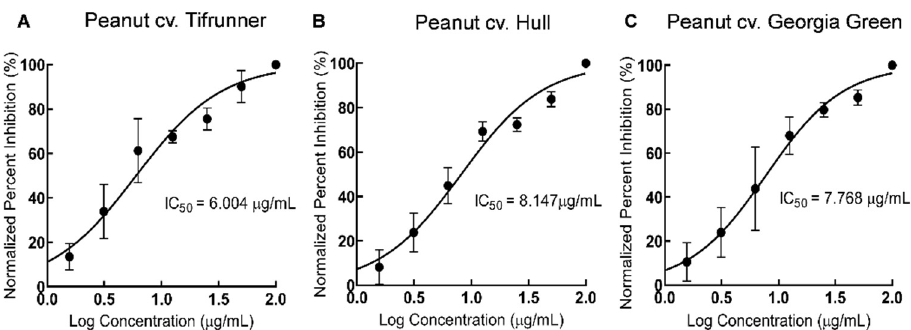
Figure 7. Concentration-dependent inhibitory effect of culture medium extracts from hairy root cultures of peanut cultivars. Tifrunner ( A ), Hull ( B ) (line 3), and Georgia Green ( C ) on DPPH based antioxidant assay. Data are represented as mean ± SD of three independent experiments, each performed in technical triplicate.